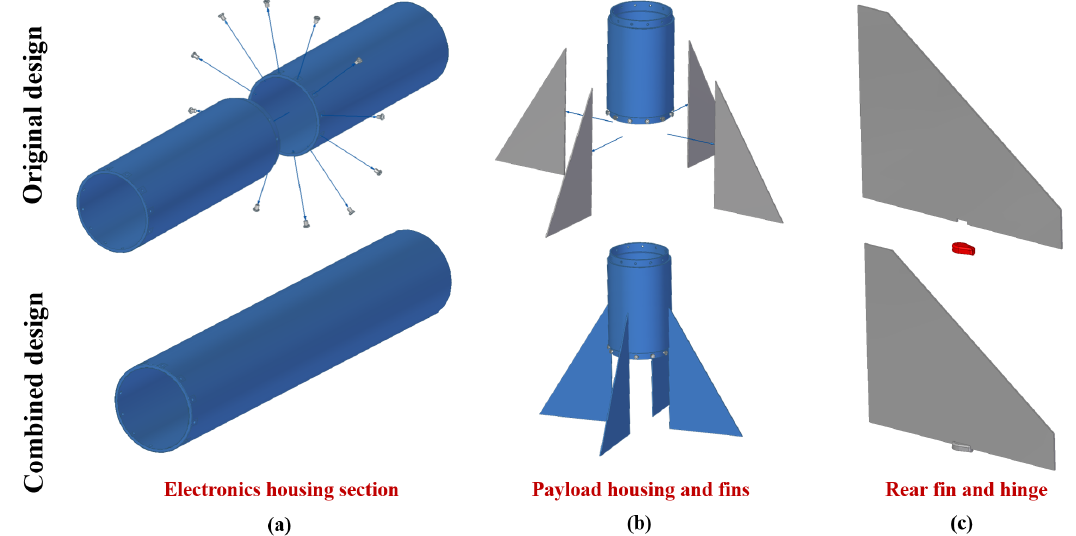
Figure 10. Part recombination opportunities for the AIM-120 AMRAAM airframe, ( a ) electronics housing; ( b ) payload section and upper fins, and ( c ) rear fins and actuator